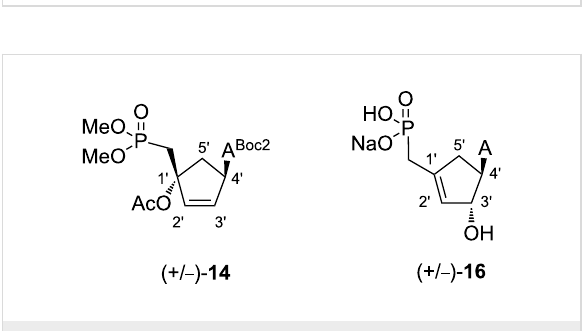
Figure 2: Numbering for 14 and 16 .